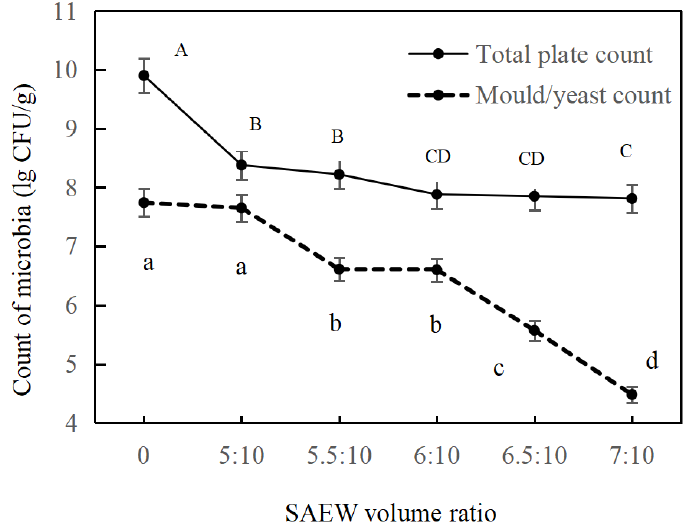
Figure 1. Effect of different volume ratio SAEW on the count of microbes in wheat kernels. The different capital letters (A–D) indicate significant differences within the total plate count; different lowercase letters (a–d) indicate significant differences ( p < 0.05) across the mould and yeast count; and 0 represents the distilled water tempering group of the control without the addition of electrolytic water. Data points for wheat tempering samples with different volume ratio SAEW are shown as mean ± SD. The error bars are derived from the standard deviation of replicates ( n = 3).